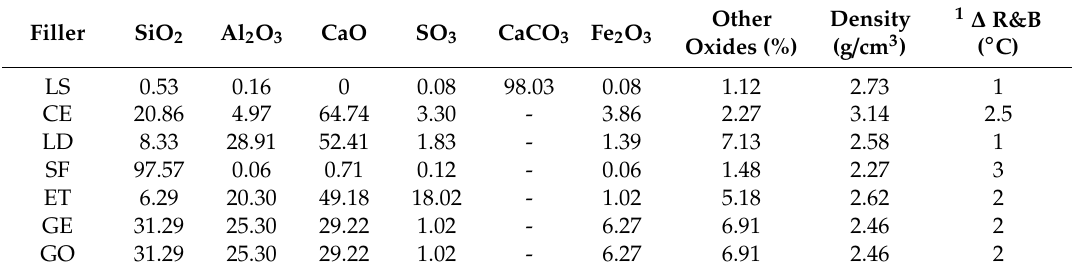
Table 1. Properties and chemical composition (wt%) of used